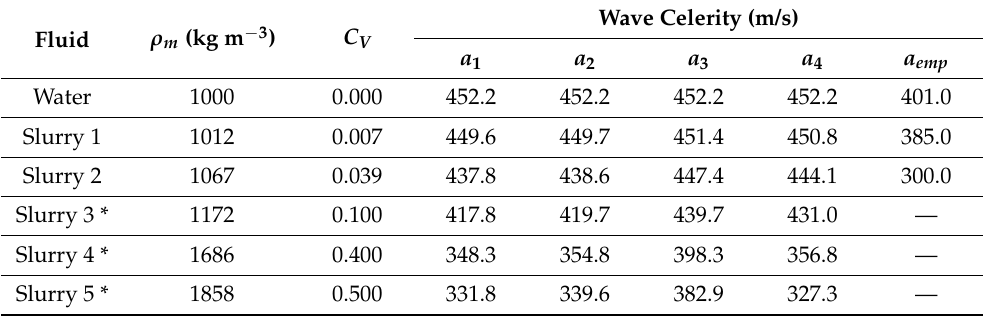
Table 1. Main parameters of selected experiments.